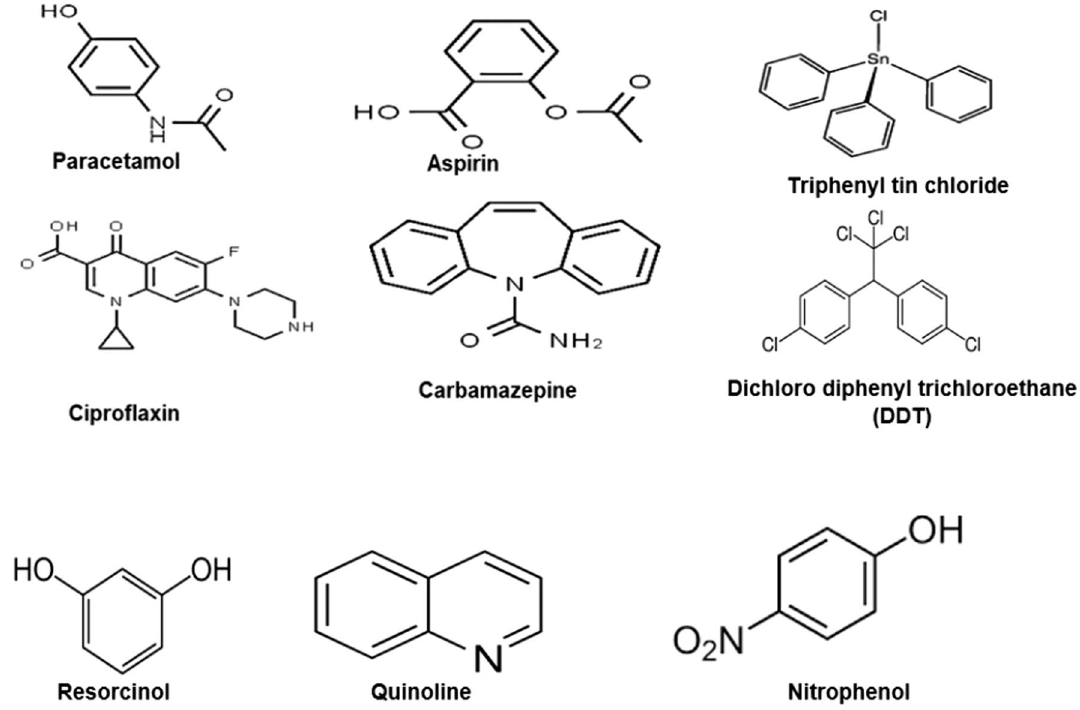
Fig. 10 Chemical structure of organic